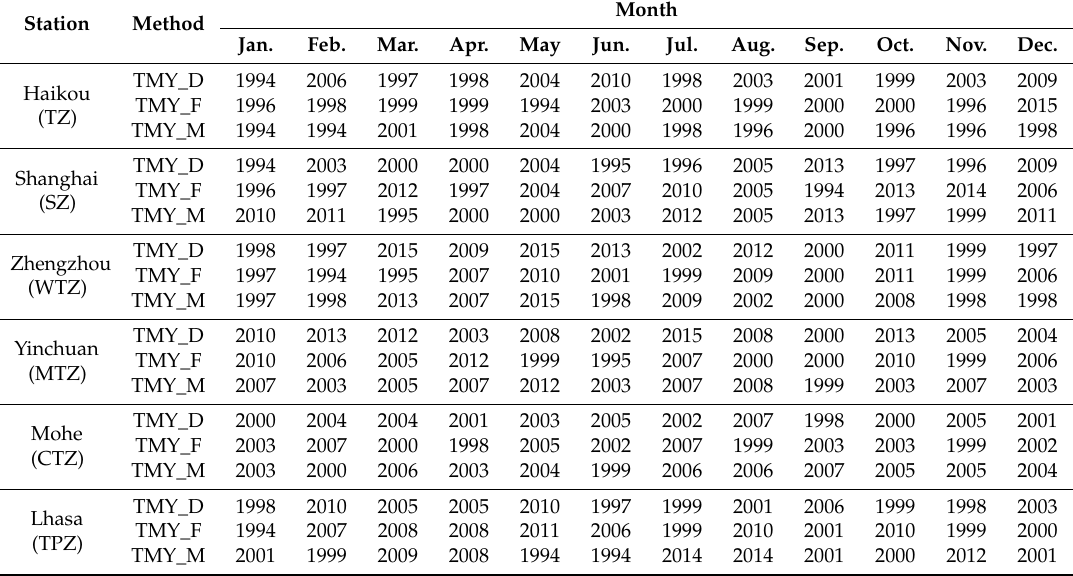
Table 3. TMYs obtained using the Danish method, Festa-Ratto method, and modified typical meteorological year method for 6 different cities in